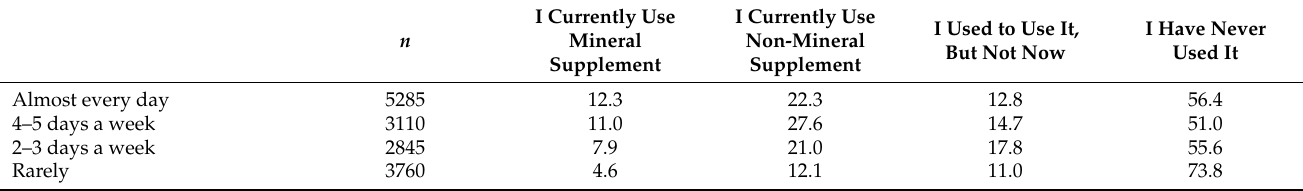
Table 5. The relationship between frequency of a well-balanced diet and prevalence of mineral supplement usage.